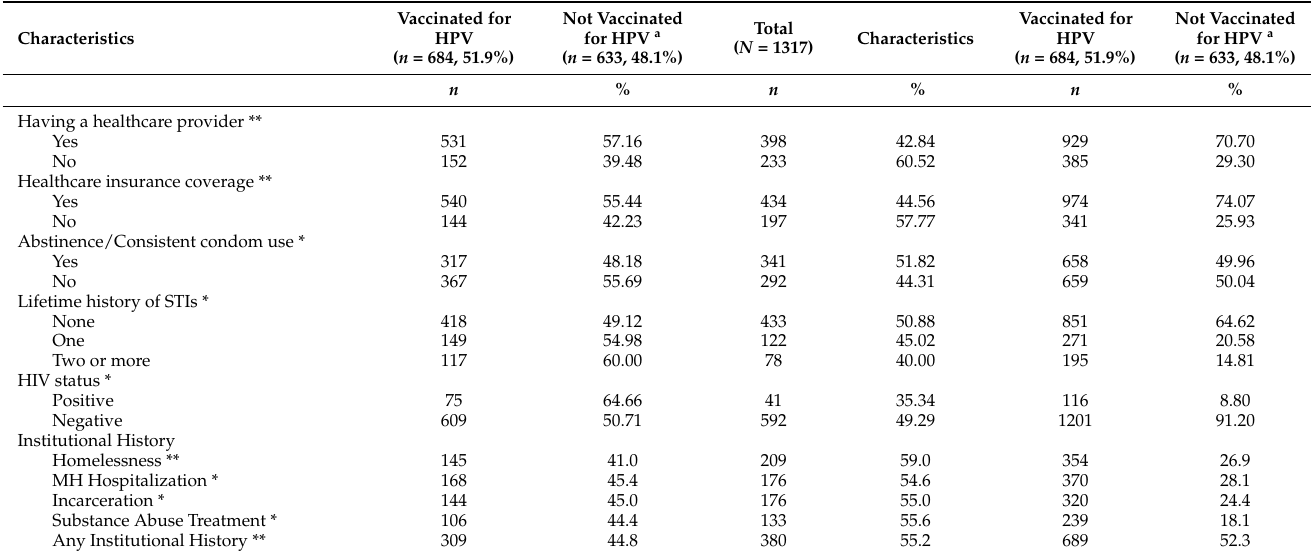
Table 2. Risk and Protective factors associated with HPV vaccination ( N = 1317).